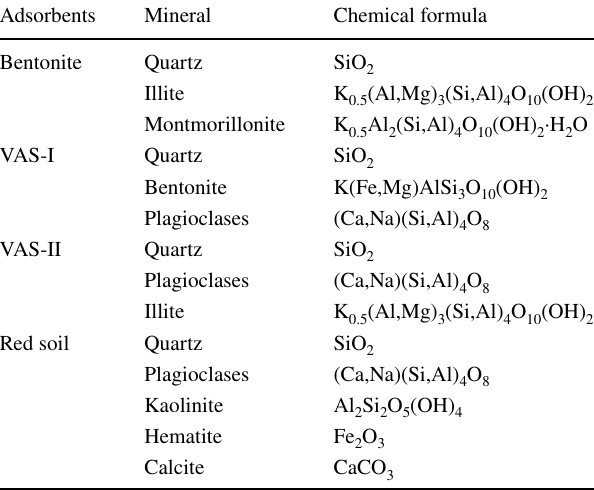
Table 3 Mineralogical composition of clay minerals adsorbents by XRD analysis